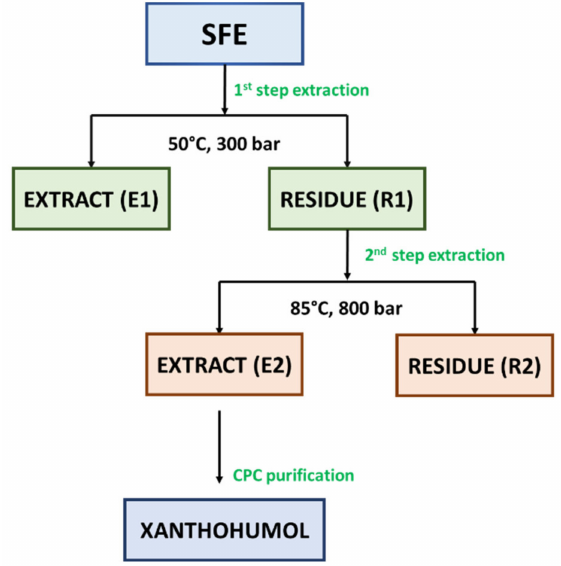
Figure 2. The scheme of the separation and purification of bioactive compounds from Marynka hop cones scCO 2 extract. Abbreviations: E—extract, CPC—centrifugal partition chromatography, R—residue, SFE—Supercritical fluid